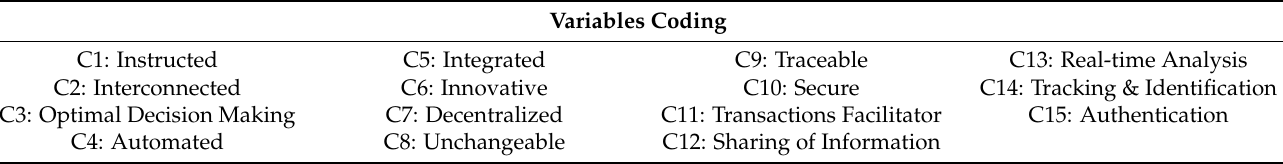
Table 2. Variables coding.